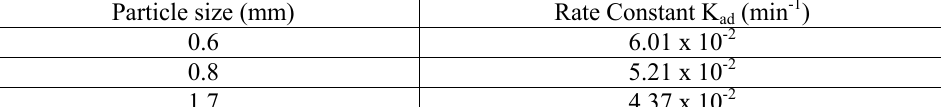
Table 8 . Lagergren rate constants calculated for different particle sizes (mm).